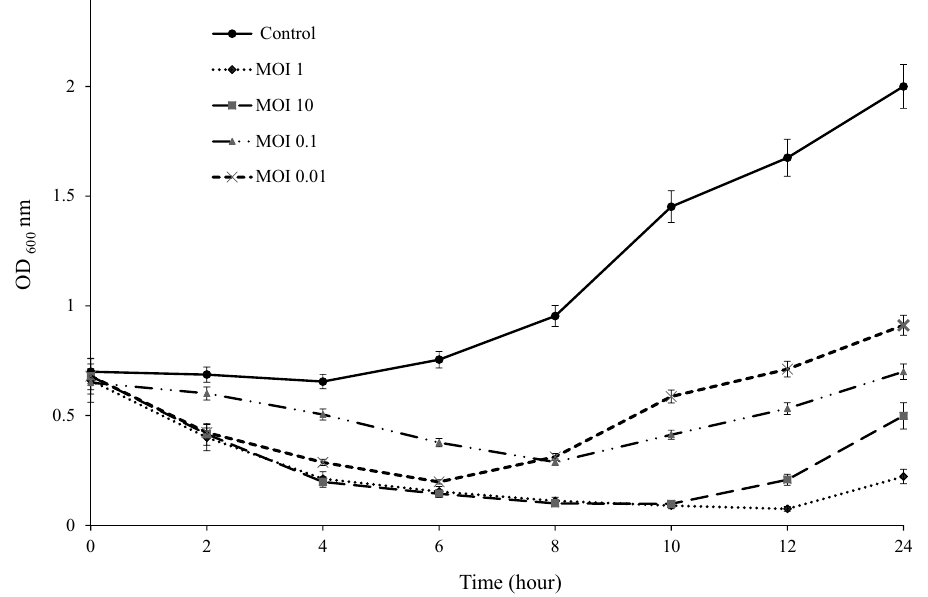
Figure 8. MOIs of vB_EfaS-SRH2 phage for E. faecalis . Error bars represent standard deviations from three